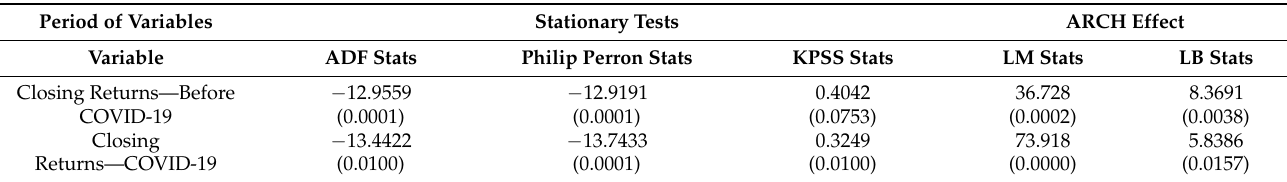
Table 2. Stationary tests and ARCH effect for PSX-100 for two selected